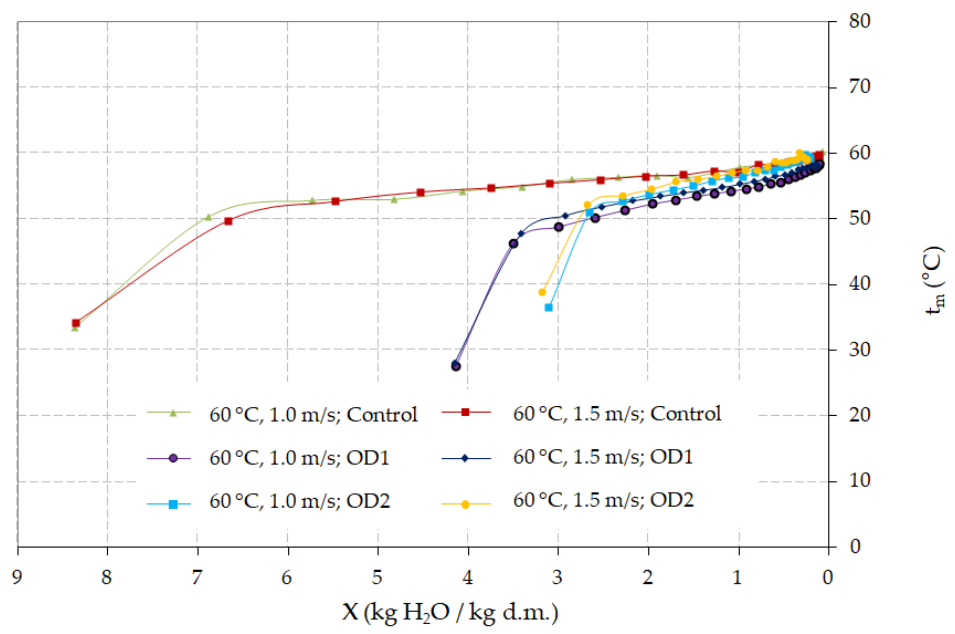
Figure 7. Temperature of apricot halves during HAD at 60 °C; 1.0 and 1.5 m/s air velocity.